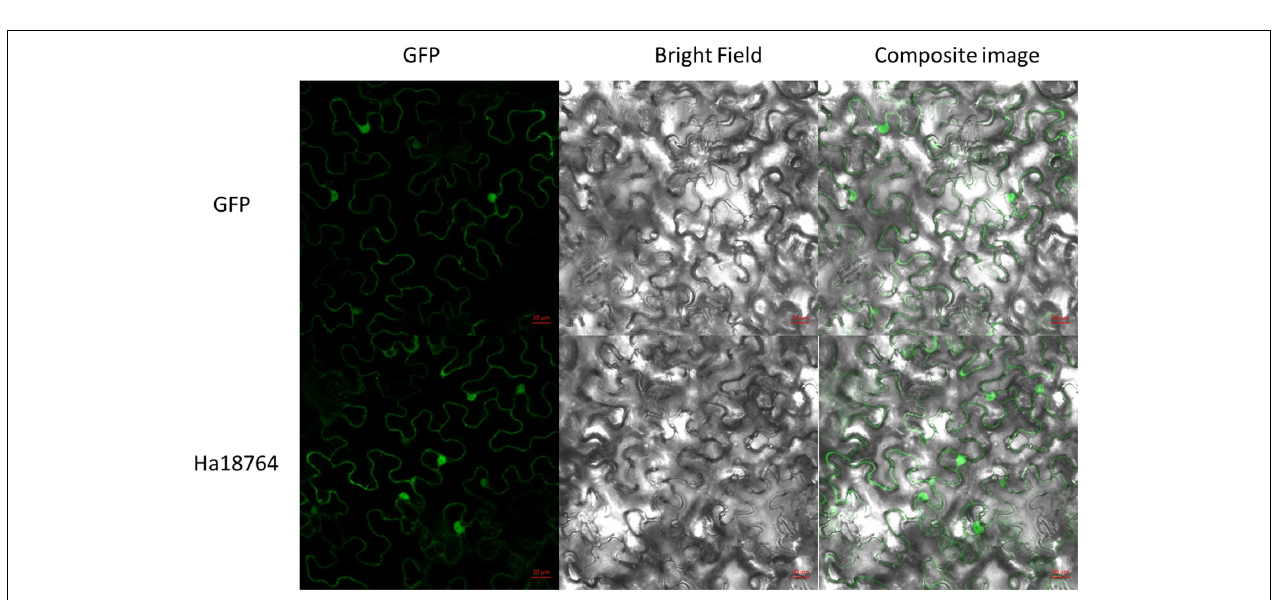
FIGURE 3 | Functional validation of the signal peptide of Ha18764 using a Magnaporthe oryzae mCherry secretion assay. The SP of Ha18764 can guide secretion of the mCherry lacking a signal sequence into the plant; hence, red fluorescence was observable in the barley cell nucleus. M. oryzae strain p131 containing the mCherryNLS construct served as a negative control. Arrows indicate barley plant nuclei. Scale bar = 20 µ m.